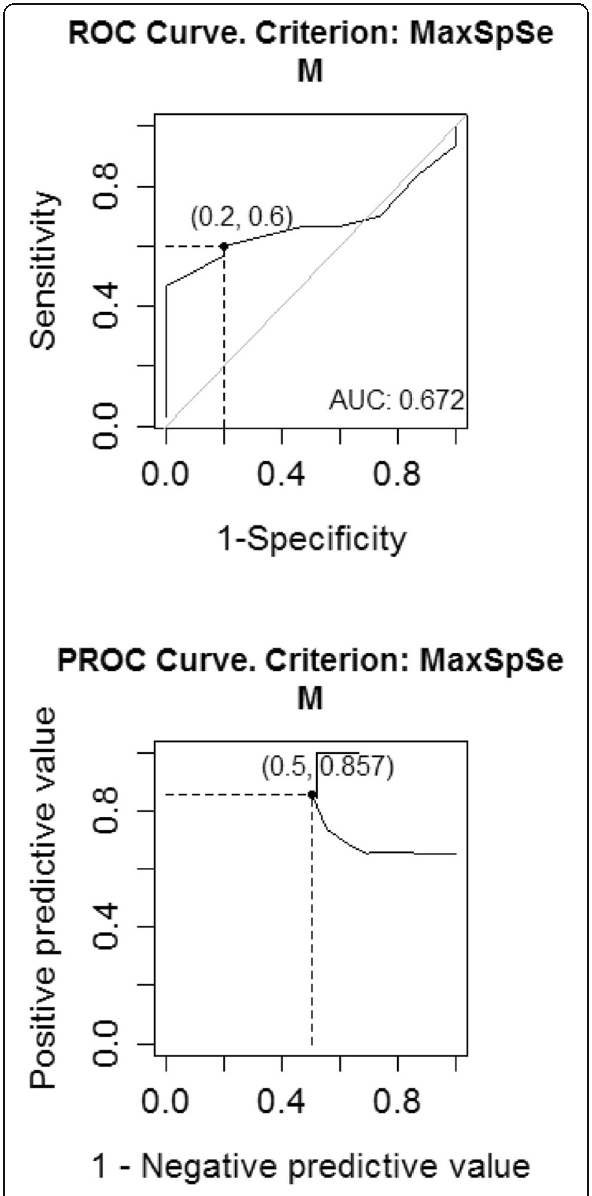
Fig. 2 ROC curve of the sensitivity, specificity, and accuracy of QTd to detect